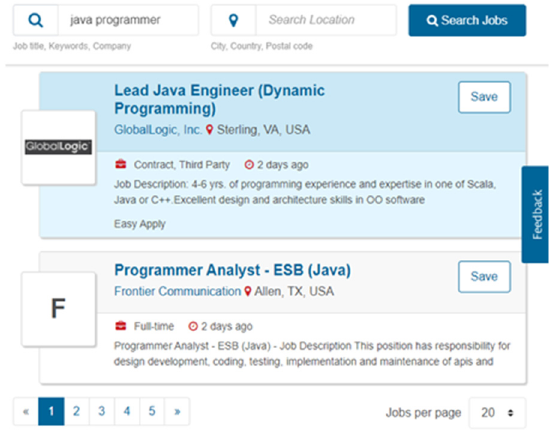
Figure 4. Example of search results using a search engine on a job portal www.dice.com (accessed on 31 August 2021).